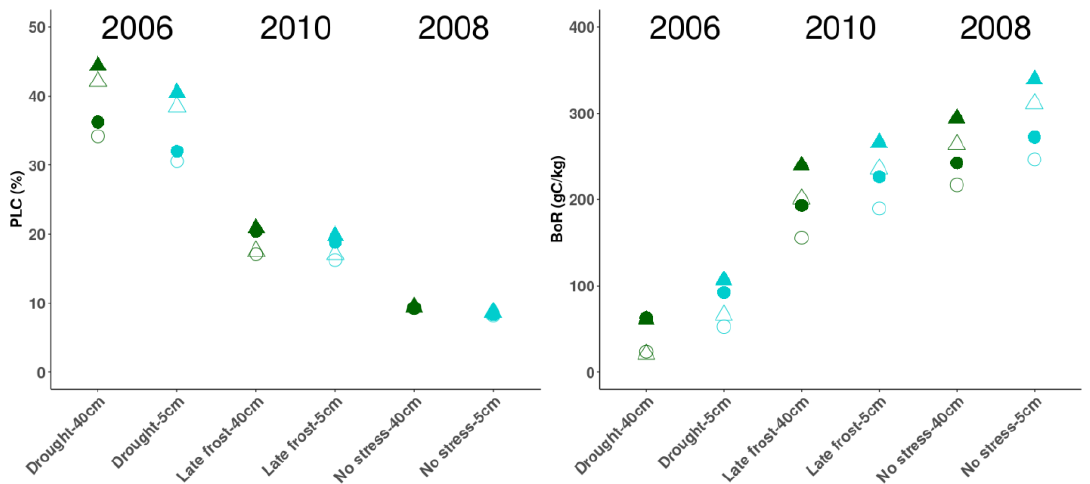
Figure 3. Physiological proxies of vulnerability simulated for eight trees differing in size, defoliation and budburst phenology. We focus on three key years: 2006 (drought); 2008 (no stress); 2010 (late frosts). Colours indicate the DBH at the beginning of the simulation: 5 cm (light blue) versus 40 cm (dark green). Triangles (re spectively round) indicate individuals with early (respectively “normal”) budburst. Empty (respectively full) indicate individuals able (respectively not able) to defoliate. PLC: percentage of loss conductance; BoR: biomass of